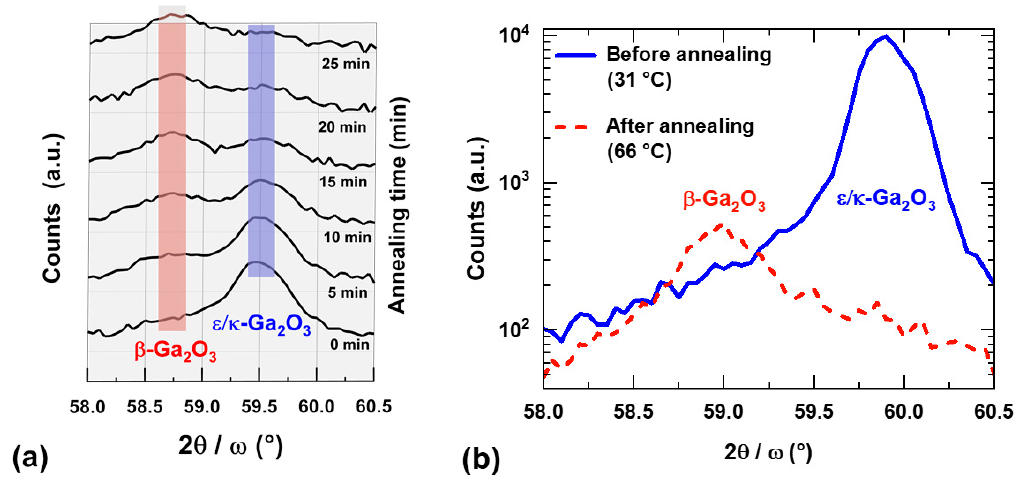
Figure 5. Time evolution of the in situ XRD symmetric 2 θ / ω scans monitored during the high-tem- perature annealing heating/cooling cycle up to 1100 °C. The right panel shows the temperature evo- lution.